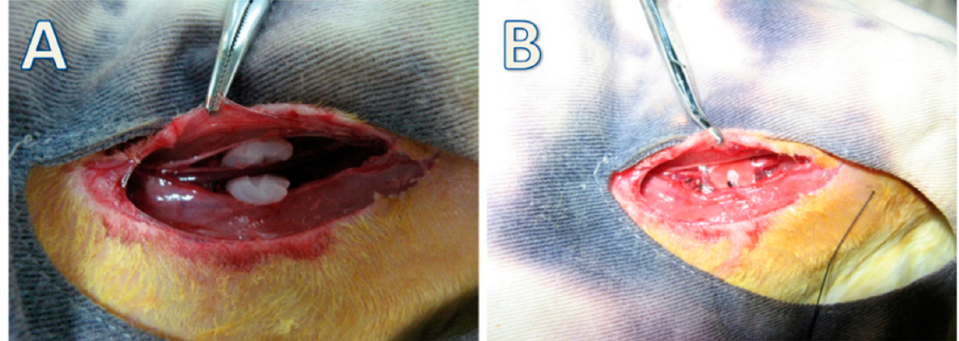
Figure 6. ( A ) The implanted BC graft in rabbit femoral artery and ( B ) their suture of the trauma. Reprinted with permission [109]. Copyright 2015 Elsevier.